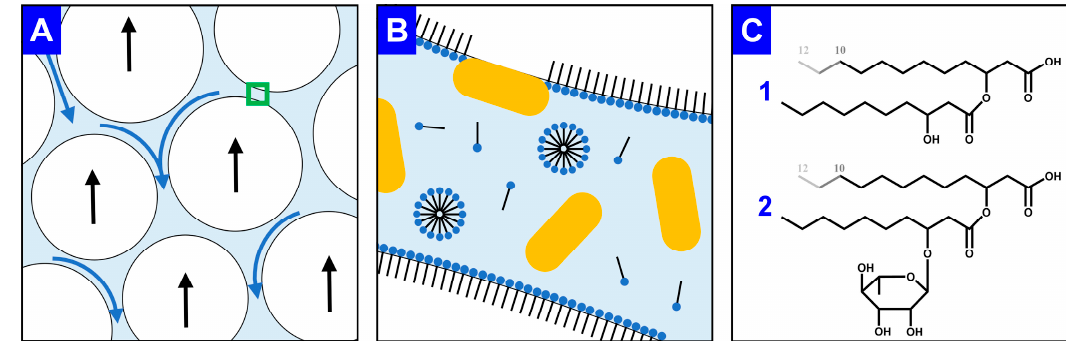
Figure 1. Graphical explanation of foam fractionation and foam stability as well as the molecular structures of RLs and HAAs. ( A ) Rising gas bubbles (white, black arrows indicate flow directions) and draining interstitial liquid (light blue, blue arrows indicate flow directions). The foam lamella marked with a green frame is enlarged in ( B ) with surfactants (black line: hydrophobic moiety; blue points: hydrophilic moiety) either adsorbed on the gas-liquid interface, agglomerated as micelles, or dissolved in the liquid. Pseudomonads (yellow) are suspended in the liquid or adsorbed on the gas-liquid interphase by hydrophobic cell surface structures. The molecular structure of the produced surfactants is shown in ( C ), for ( 1 ) HAA and ( 2 ) mono-RL, considering that the hydrocarbon chain length varies between C 8 and C 12 for the applied whole-cell biocatalysts.